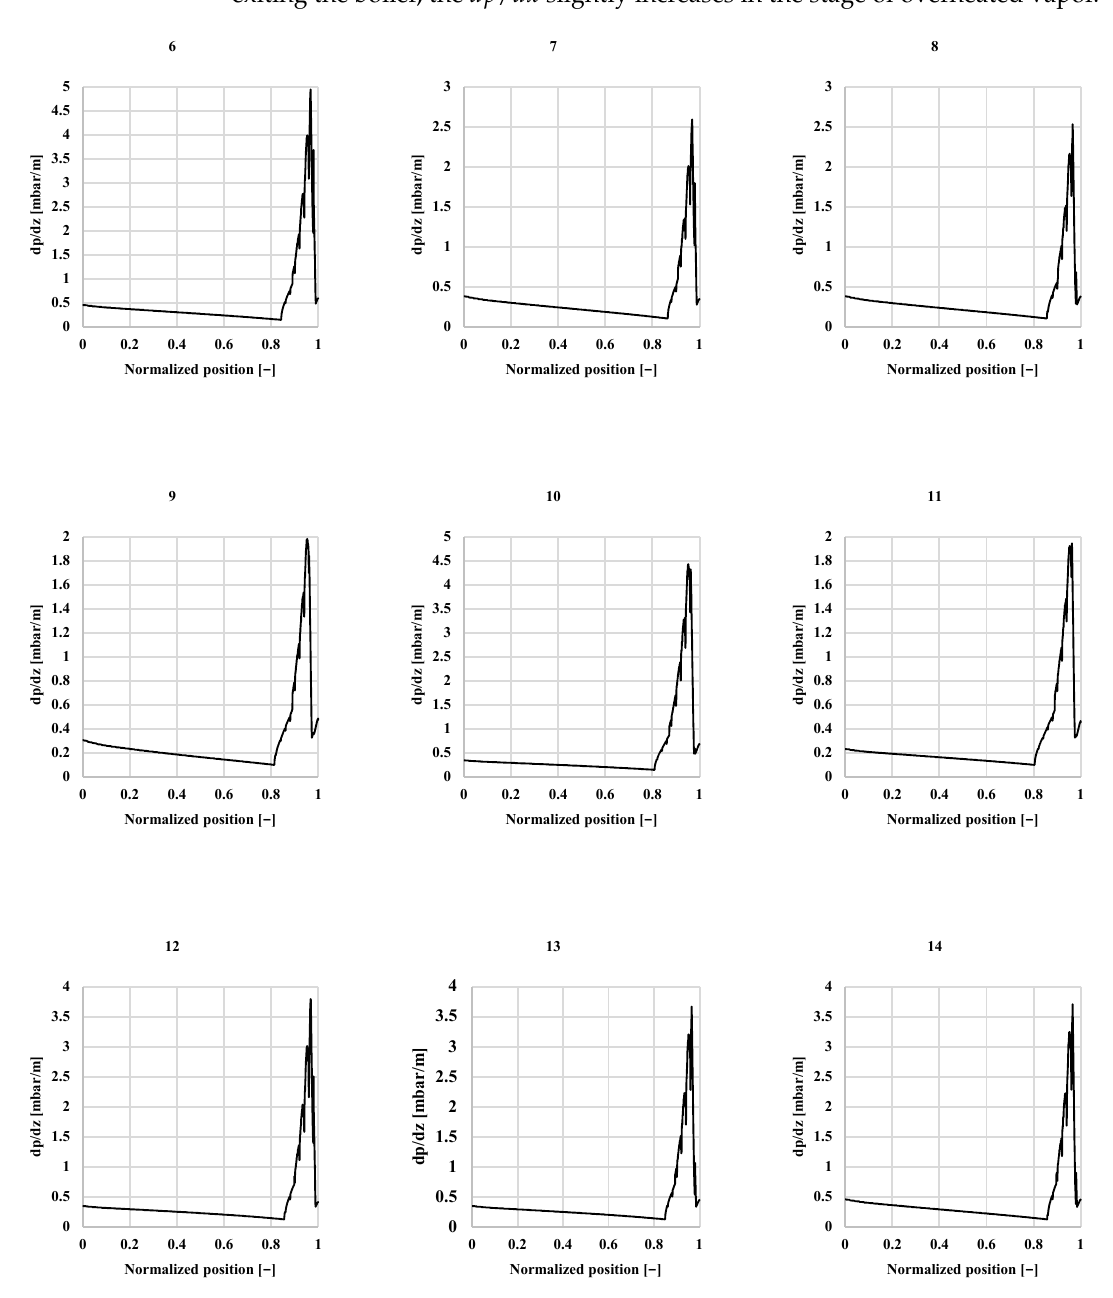
Figure 8. Pressure drop per unit of length of the path of the WF in the experiments analyzed, experiment codes from 6 to 14.